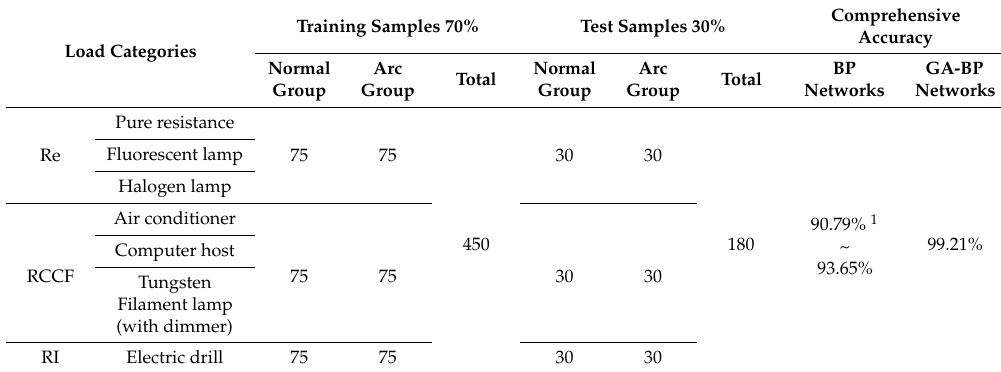
Table 7. Fault arc identification results.